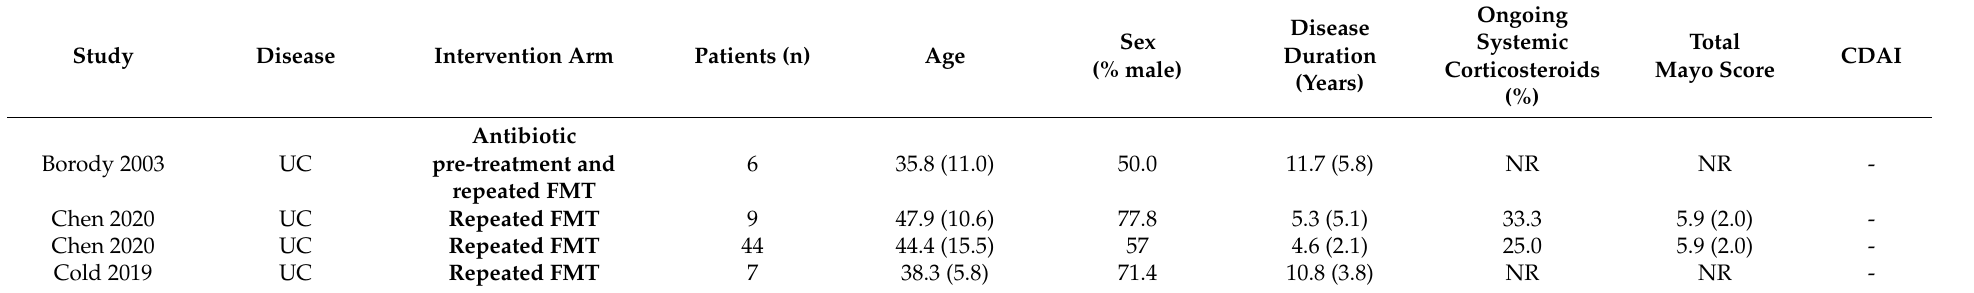
Table 2. Baseline characteristics of patients for included